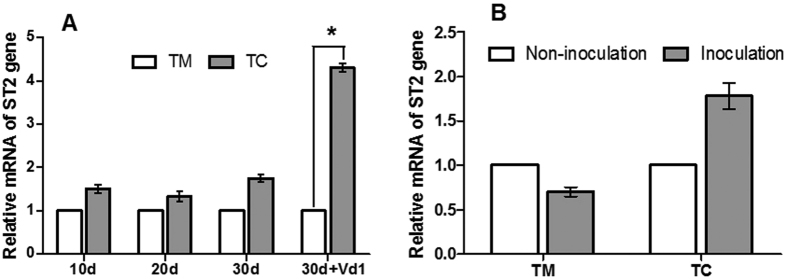
Relative mRNA expression of the ST2 gene in tomato roots infected by V. dahliae in tomato/potato onion companion cropping.(A) Effect of companion cropping with potato onions on the relative mRNA expression of the ST2 gene. (B) Effect of V. dahliae inoculation on the relative mRNA expression of the ST2 gene. TM indicates tomato monoculture; TC means tomato grown with potato onions; and 10 d, 20 d and 30 d indicate companion cropping with potato onion for 10, 20 and 30 days, respectively. 30 d + Vd1 indicates companion cropping with potato onion for 30 days with simultaneous Vd1 inoculation starting at day 20. Vd1 indicates V. dahliae race 1. The data are presented as the means ± SD, n = 3. The asterisk (*) indicates a significant difference between two groups of mean values (p < 0.05).